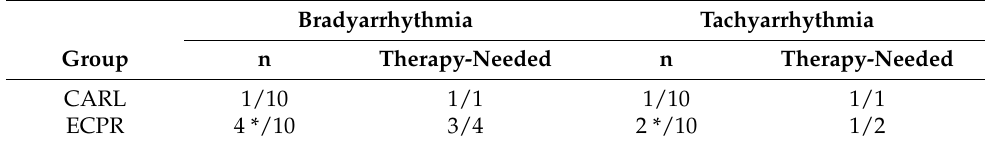
Table 4. Cardiac arrhythmias during reperfusion.